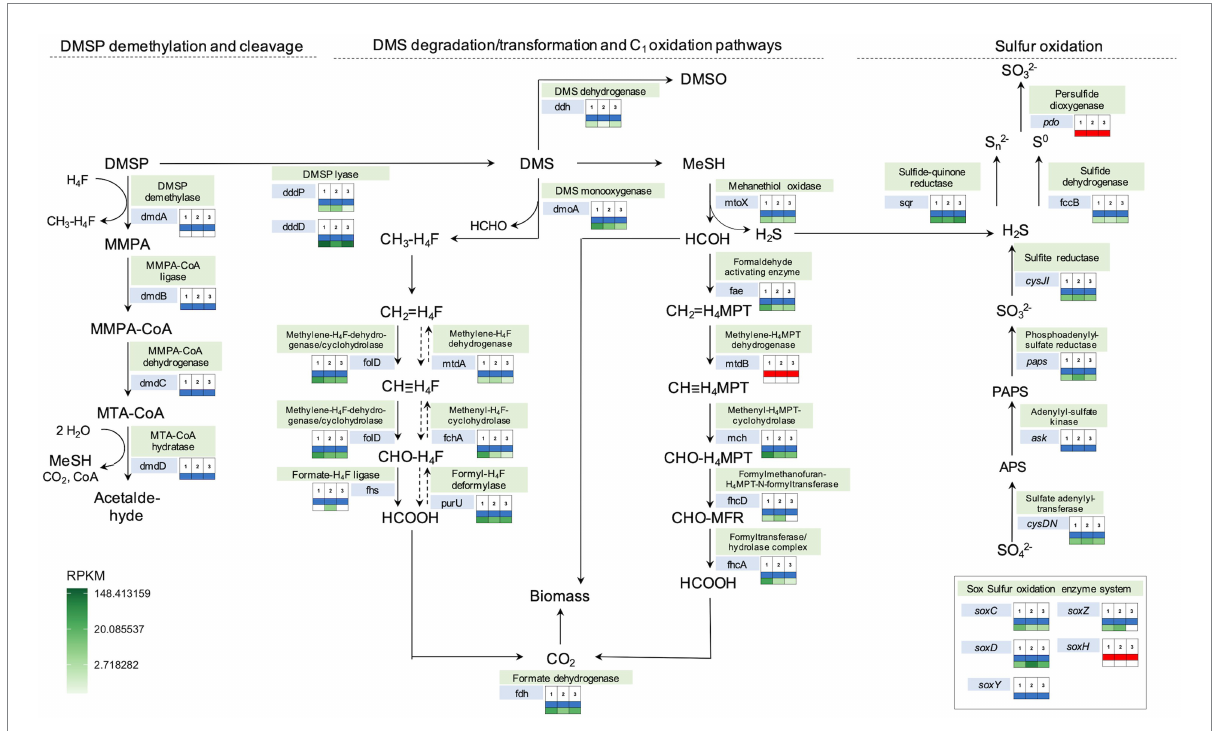
FIGURE 7 Metabolic pathways involved in DMS degradation/transformation, one-carbon and sulfur oxidation annotated with presence/absence and abundance (RPKM) of specific genes in the three Sporobolus anglicus phyllosphere metagenomes. The analysis is based on Prokka annotations, tBLASTn, BLASTx, and shortBRED gene searches among the three different S. anglicus phyllosphere metagenomes (1–3). The colour-coded boxes next to the genes indicate the presence (blue) or absence (red) of a gene in each metagenome inferred by BLAST searches (second table row) and the abundance of these genes in Sporobolus metagenomic reads in reads per kilo base per million mapped reads (RPKM) shown as heatmap colours (third table row). Exact RPKM values and explanation of abbreviations can be found in Supplementary Table 2. DMSP, dimethylsulfoniopropionate; DMS, dimethylsulfide; MMPA-3, methiolpropionate; MTA, 5’-Desoxy-5 ′ -methylthioadenosin; HCHO, formaldehyde; APS, adenosine phosphosulfate; and PAPS, phosphoadenosine 5 ′